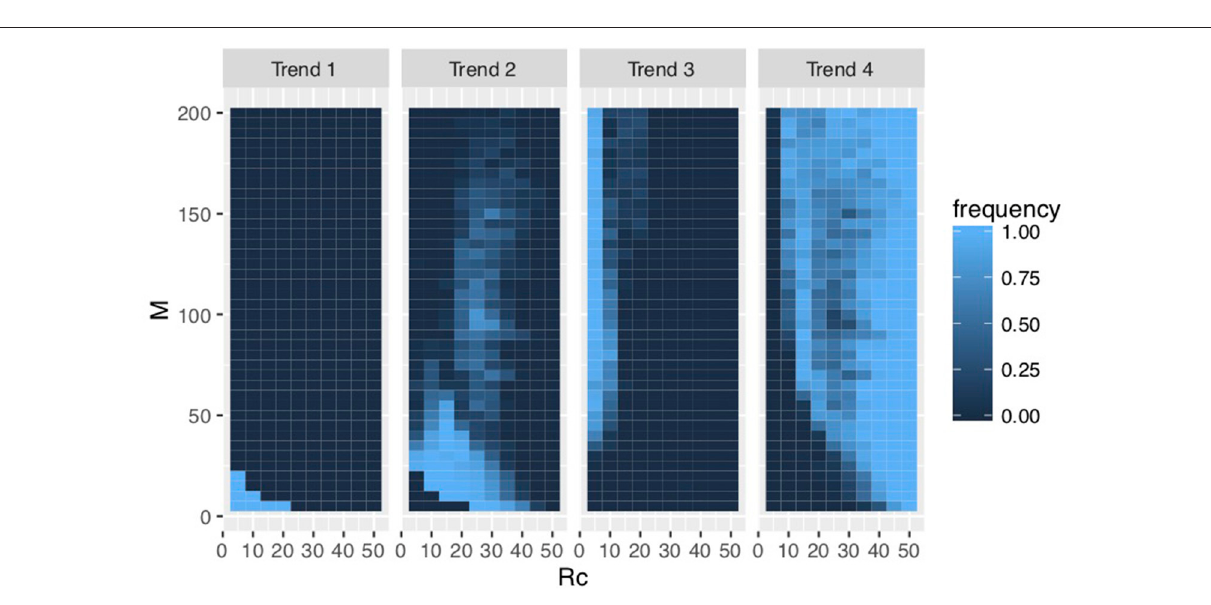
FIGURE 4 | Frequencies of evolution in each trend ( R g = 300). Trend 1 evolved when R c M was small. Trend 4 evolved when R c M was large. Trends 2 and 3 evolved in the intermediate range between trends 1 and 4 where R c / M determined whether groomers evolved to trend 2 or 3. Additionally, R g increased a range of group sizes M in which social grooming strategies evolved to trend 2 or 3, i.e., a large amount of social grooming evolved to trends 2 and 3 in large